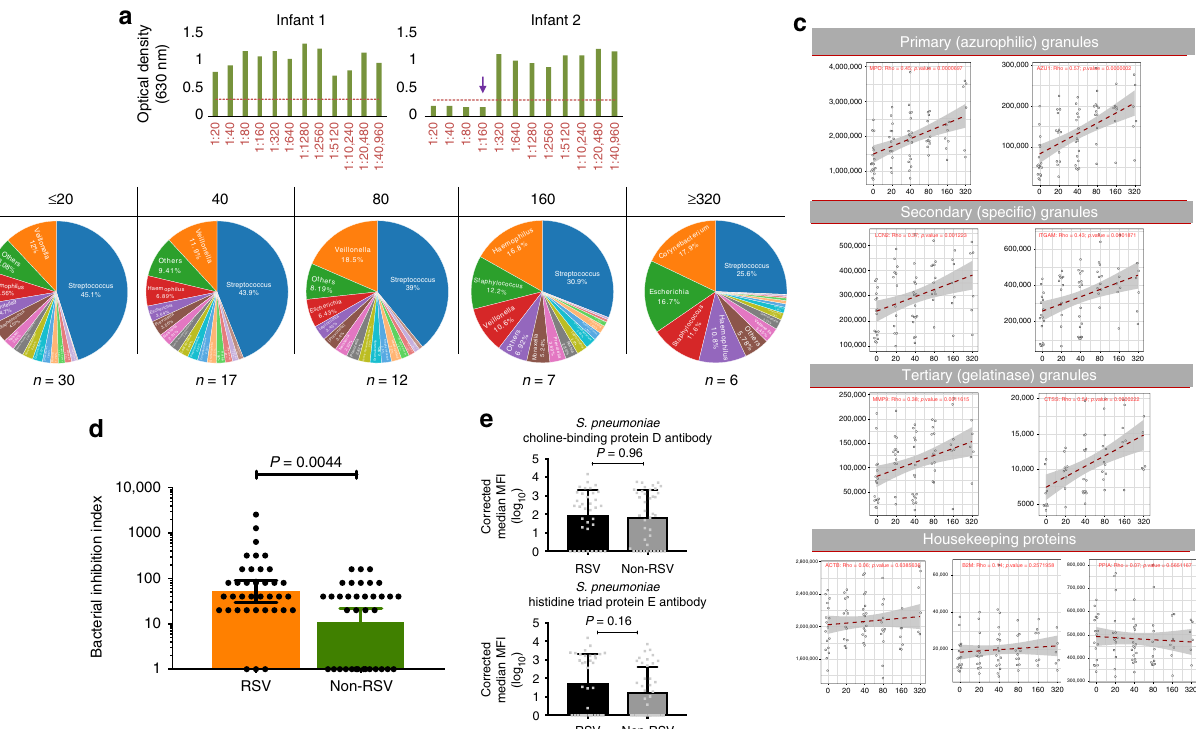
Fig. 3 Analysis of bacterial inhibition activity in airway secretions. a Example plots of children with different bacterial inhibition activities. The y -axis represents the optical density which is directly related to the amount of bacterial ( Streptococcus pneumoniae ) growth: bacterial growth increases turbidity of the culture media resulting in a proportional increase in optical density. The x -axis represents a doubling dilution of nasal samples from 1:20 to 1:40,960. The dashed horizontal red line denotes an optical density cutoff above which substantial turbidity of the culture media was observed. Nasal secretions from infant 1 were unable to inhibit bacterial growth at any dilution (bacterial inhibition index [BII] = 0). Nasal secretions from infant 2 completely inhibited pneumococcal growth at dilutions ≤ 1:160 (BII = 160). b Children were categorised into fi ve BII strata and differences in the proportional abundance of different bacterial taxa in each stratum presented in pie charts. The airway abundance of Streptococcus decreased with increasing bacterial inhibition activity. c Bacterial inhibition activity in nasal samples ( N = 72) was correlated with the expression levels of neutrophil-granule proteins (strati fi ed by functional subset). Representative proteins from all three subsets of neutrophil granules (azurophilic, speci fi c and gelatinase) were positively correlated with bacterial inhibition activity (complete analysis of the correlation between bacterial inhibition activity and all the neutrophil granule proteins can be found in Supplementary Fig. 2). In contrast, there was no correlation between the expression levels of housekeeping proteins (ACTB, B2M and PPIA) and bacterial inhibition activity in nasal samples. Correlation analysis was done using Spearman ’ s rank order correlation. d Bacterial inhibition activity was compared between RSV-positive ( N = 36) and RSV-negative children ( N = 36). The mean BII level in RSV-infected children (geometric mean: 52) was signi fi cantly greater than the mean BII in RSV-negative children (geometric mean: 10.9). Error bars indicate 95% con fi dence intervals. e Mean airway IgG levels to two Streptococcus pneumoniae proteins (choline-binding protein D and Histidine Triad protein E) were compared between RSV-positive ( N = 36) and RSV-negative children ( N = 36). Error bars indicate 95% con fi dence intervals. P -values in d and e were based on Mann – Whitney U -test. Source